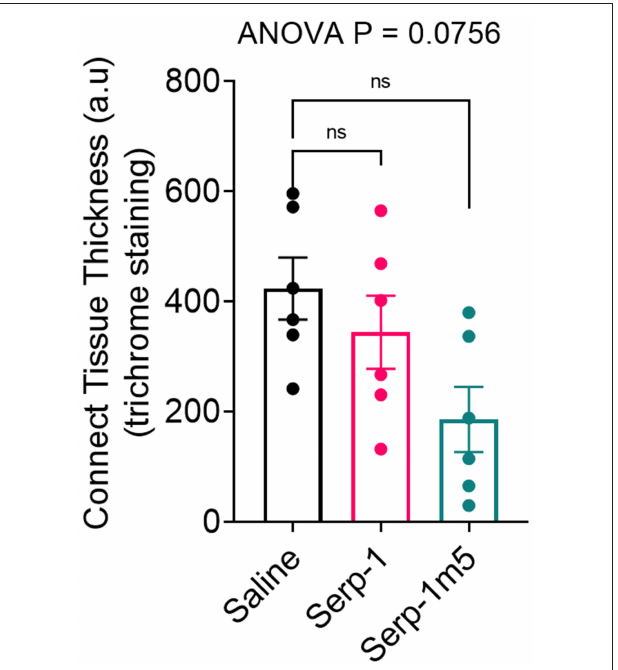
FIGURE 4 | Trichrome staining indicated a nonsignificant increase in collagen staining in areas of hemorrhage in the saline treated controls. Serp-1 and Serp-1m5 treatment produced a non-significant decrease in fibrous tissue staining, here illustrated as measured thickness of fibrous tissue.